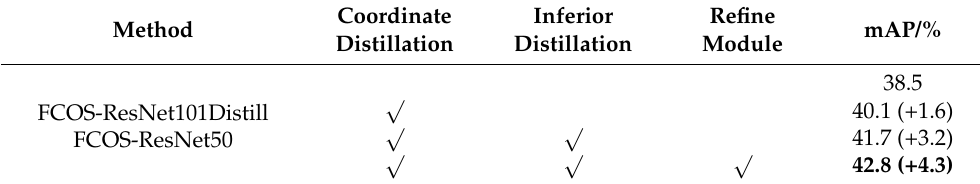
Table 3. Ablation study of